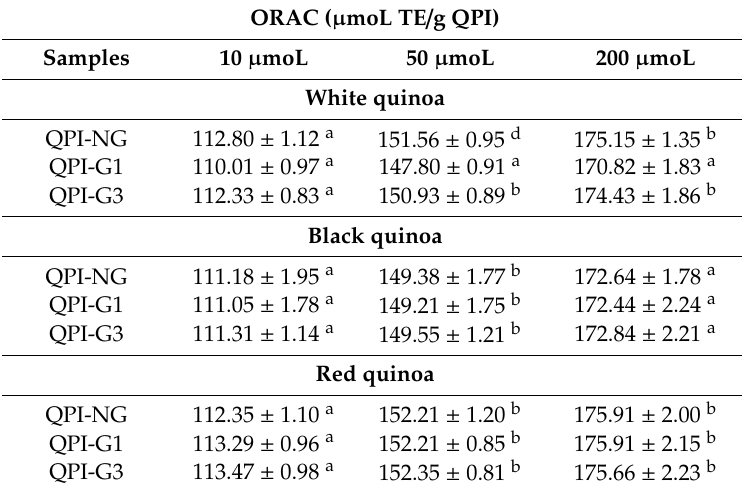
Table 3. Antioxidant activity of non-germinated and germinated QPIs of white, red and black quinoas using the ORAC